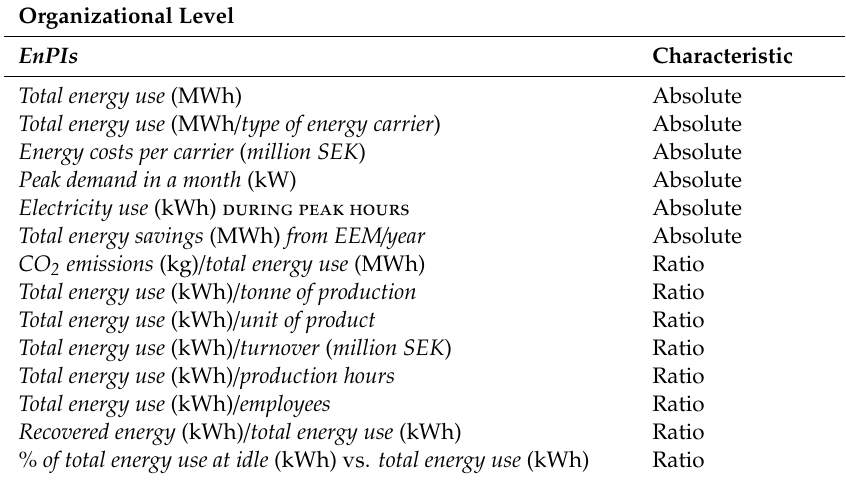
Table 4. EnPIs identified for organizational level for the engineering